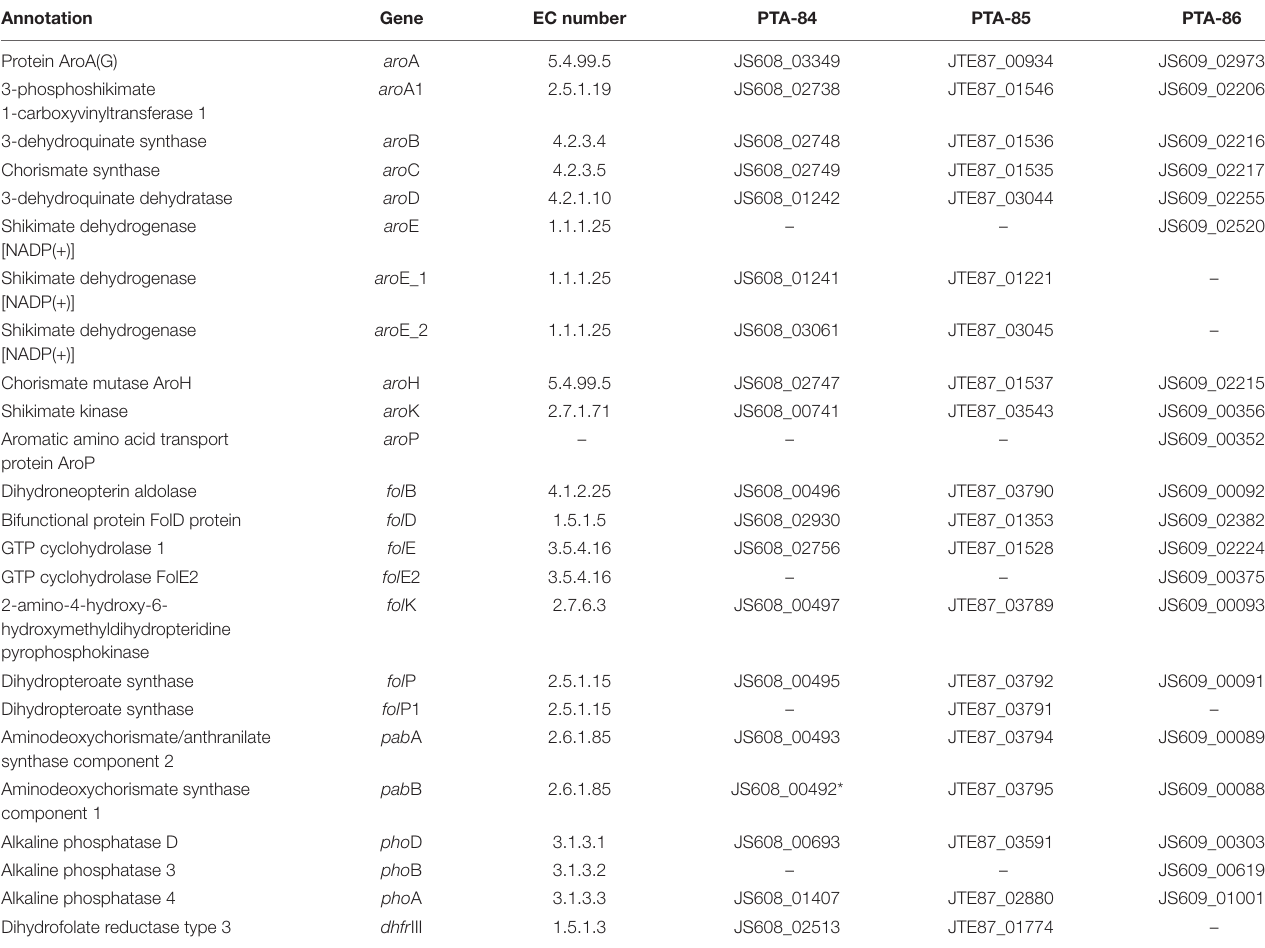
TABLE 3 | Genes involved in folate biosynthetic pathway in probiotic Bacillus spp.